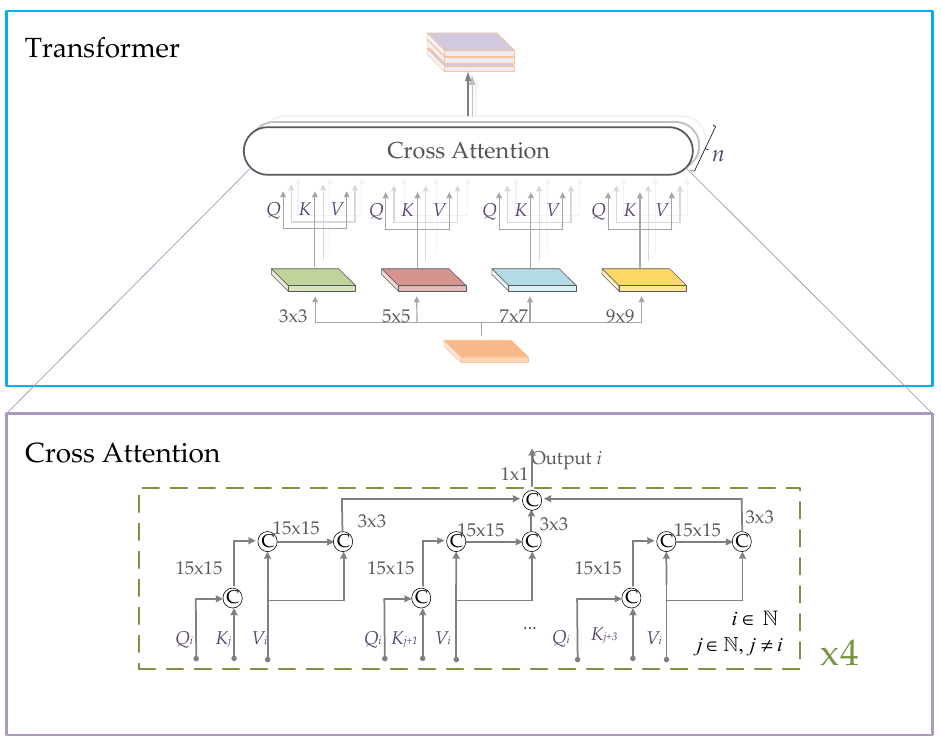
Figure 2. Our transformer structure and its internal structure diagram.